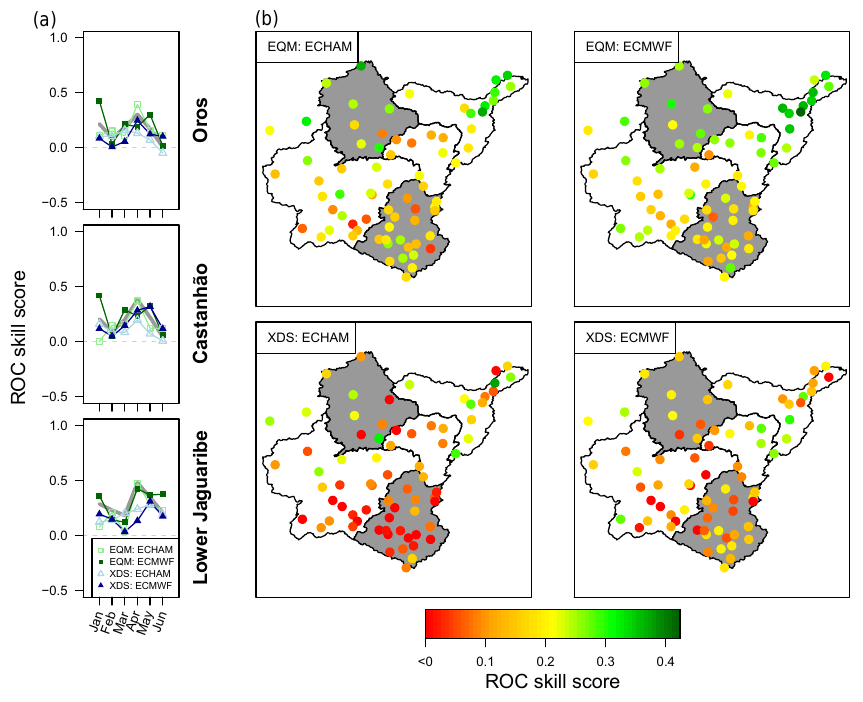
Figure 5. ROCSS of the forecast of a monthly low precipitation event. (a) The ROCSS is shown for each model/downscaling combination and for the forecasting months averaged over the respective subcatchments. Panels (b) show ROCSS averaged over all forecasting months for each station.